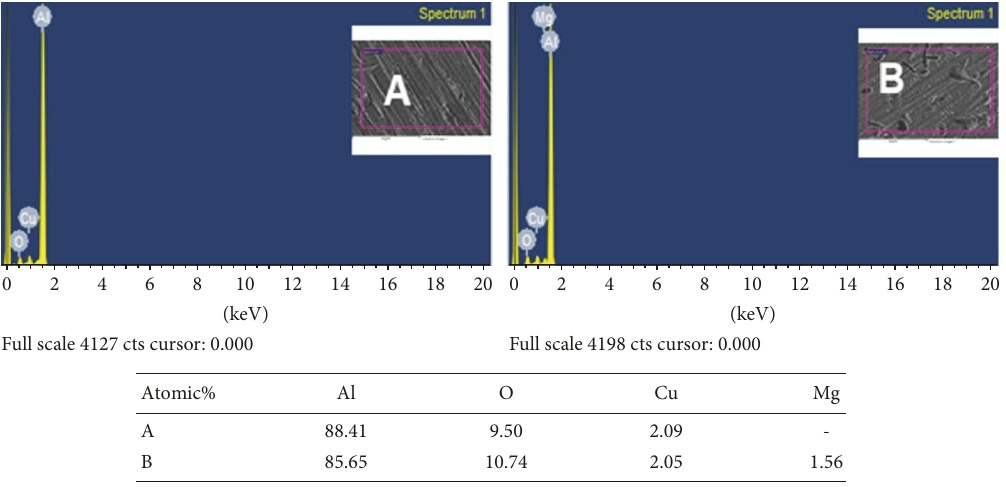
due to polishing. Heterogeneous nature of aluminum alloys surfaces is evident by images “A”. SEM images “B” show damaged surfaces due to localized attack by the Red Sea